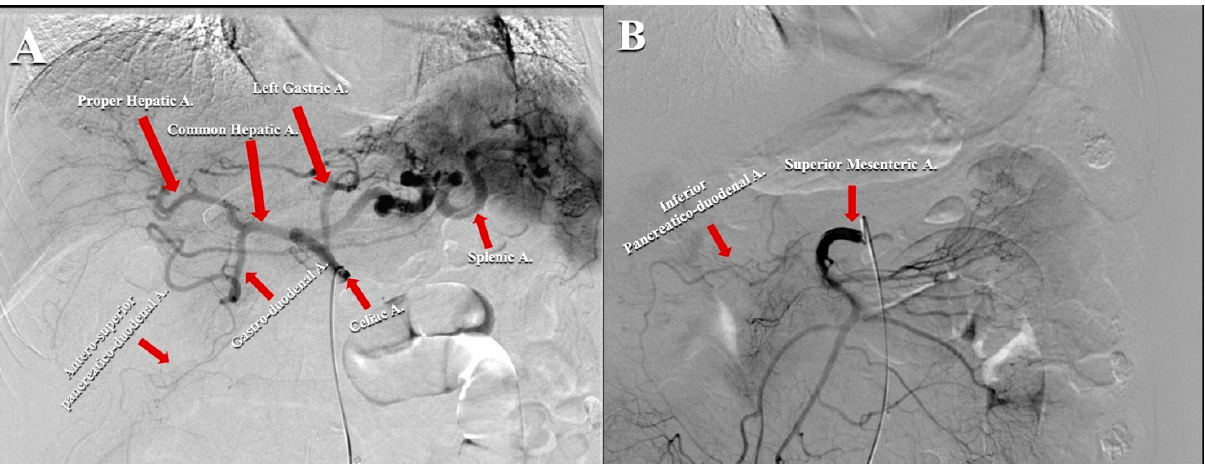
Figure 1. ( A ) Angiographic scan representing the vascular anatomy of celiac artery. ( B ) Angiographic scan representing vascular anatomy of superior mesenteric artery.